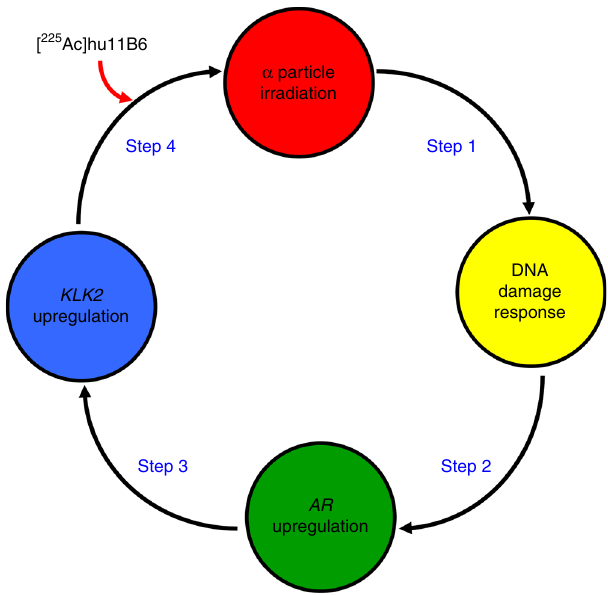
Fig. 7 The mechanism of action in alpha particle-promoted feed-forward oncoaddiction. The interaction of α -particles with tumor tissue produces DNA damage. The ensuing transcriptional response prompts the hormone- DNA circuit to upregulate AR expression. KLK2 expression subsequently upregulates due to AR and produces more hk2 target epitope for [ 225 Ac]